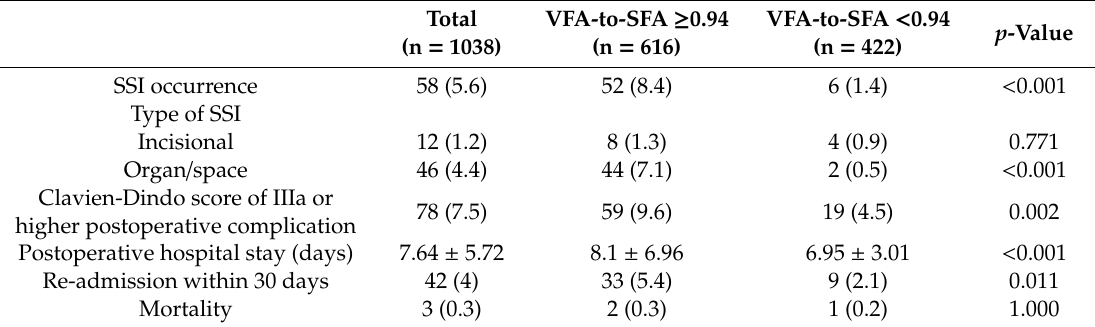
Table 5. Comparison of treatment outcomes after gastrectomy according to abdominal fat